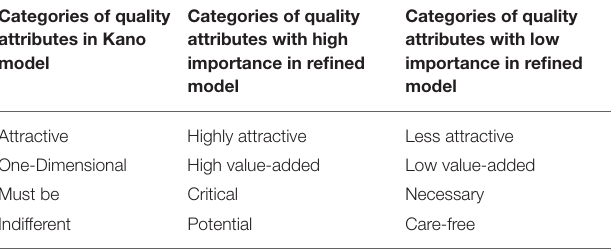
TABLE 3 | Categories of quality attributes in refined Kano model.